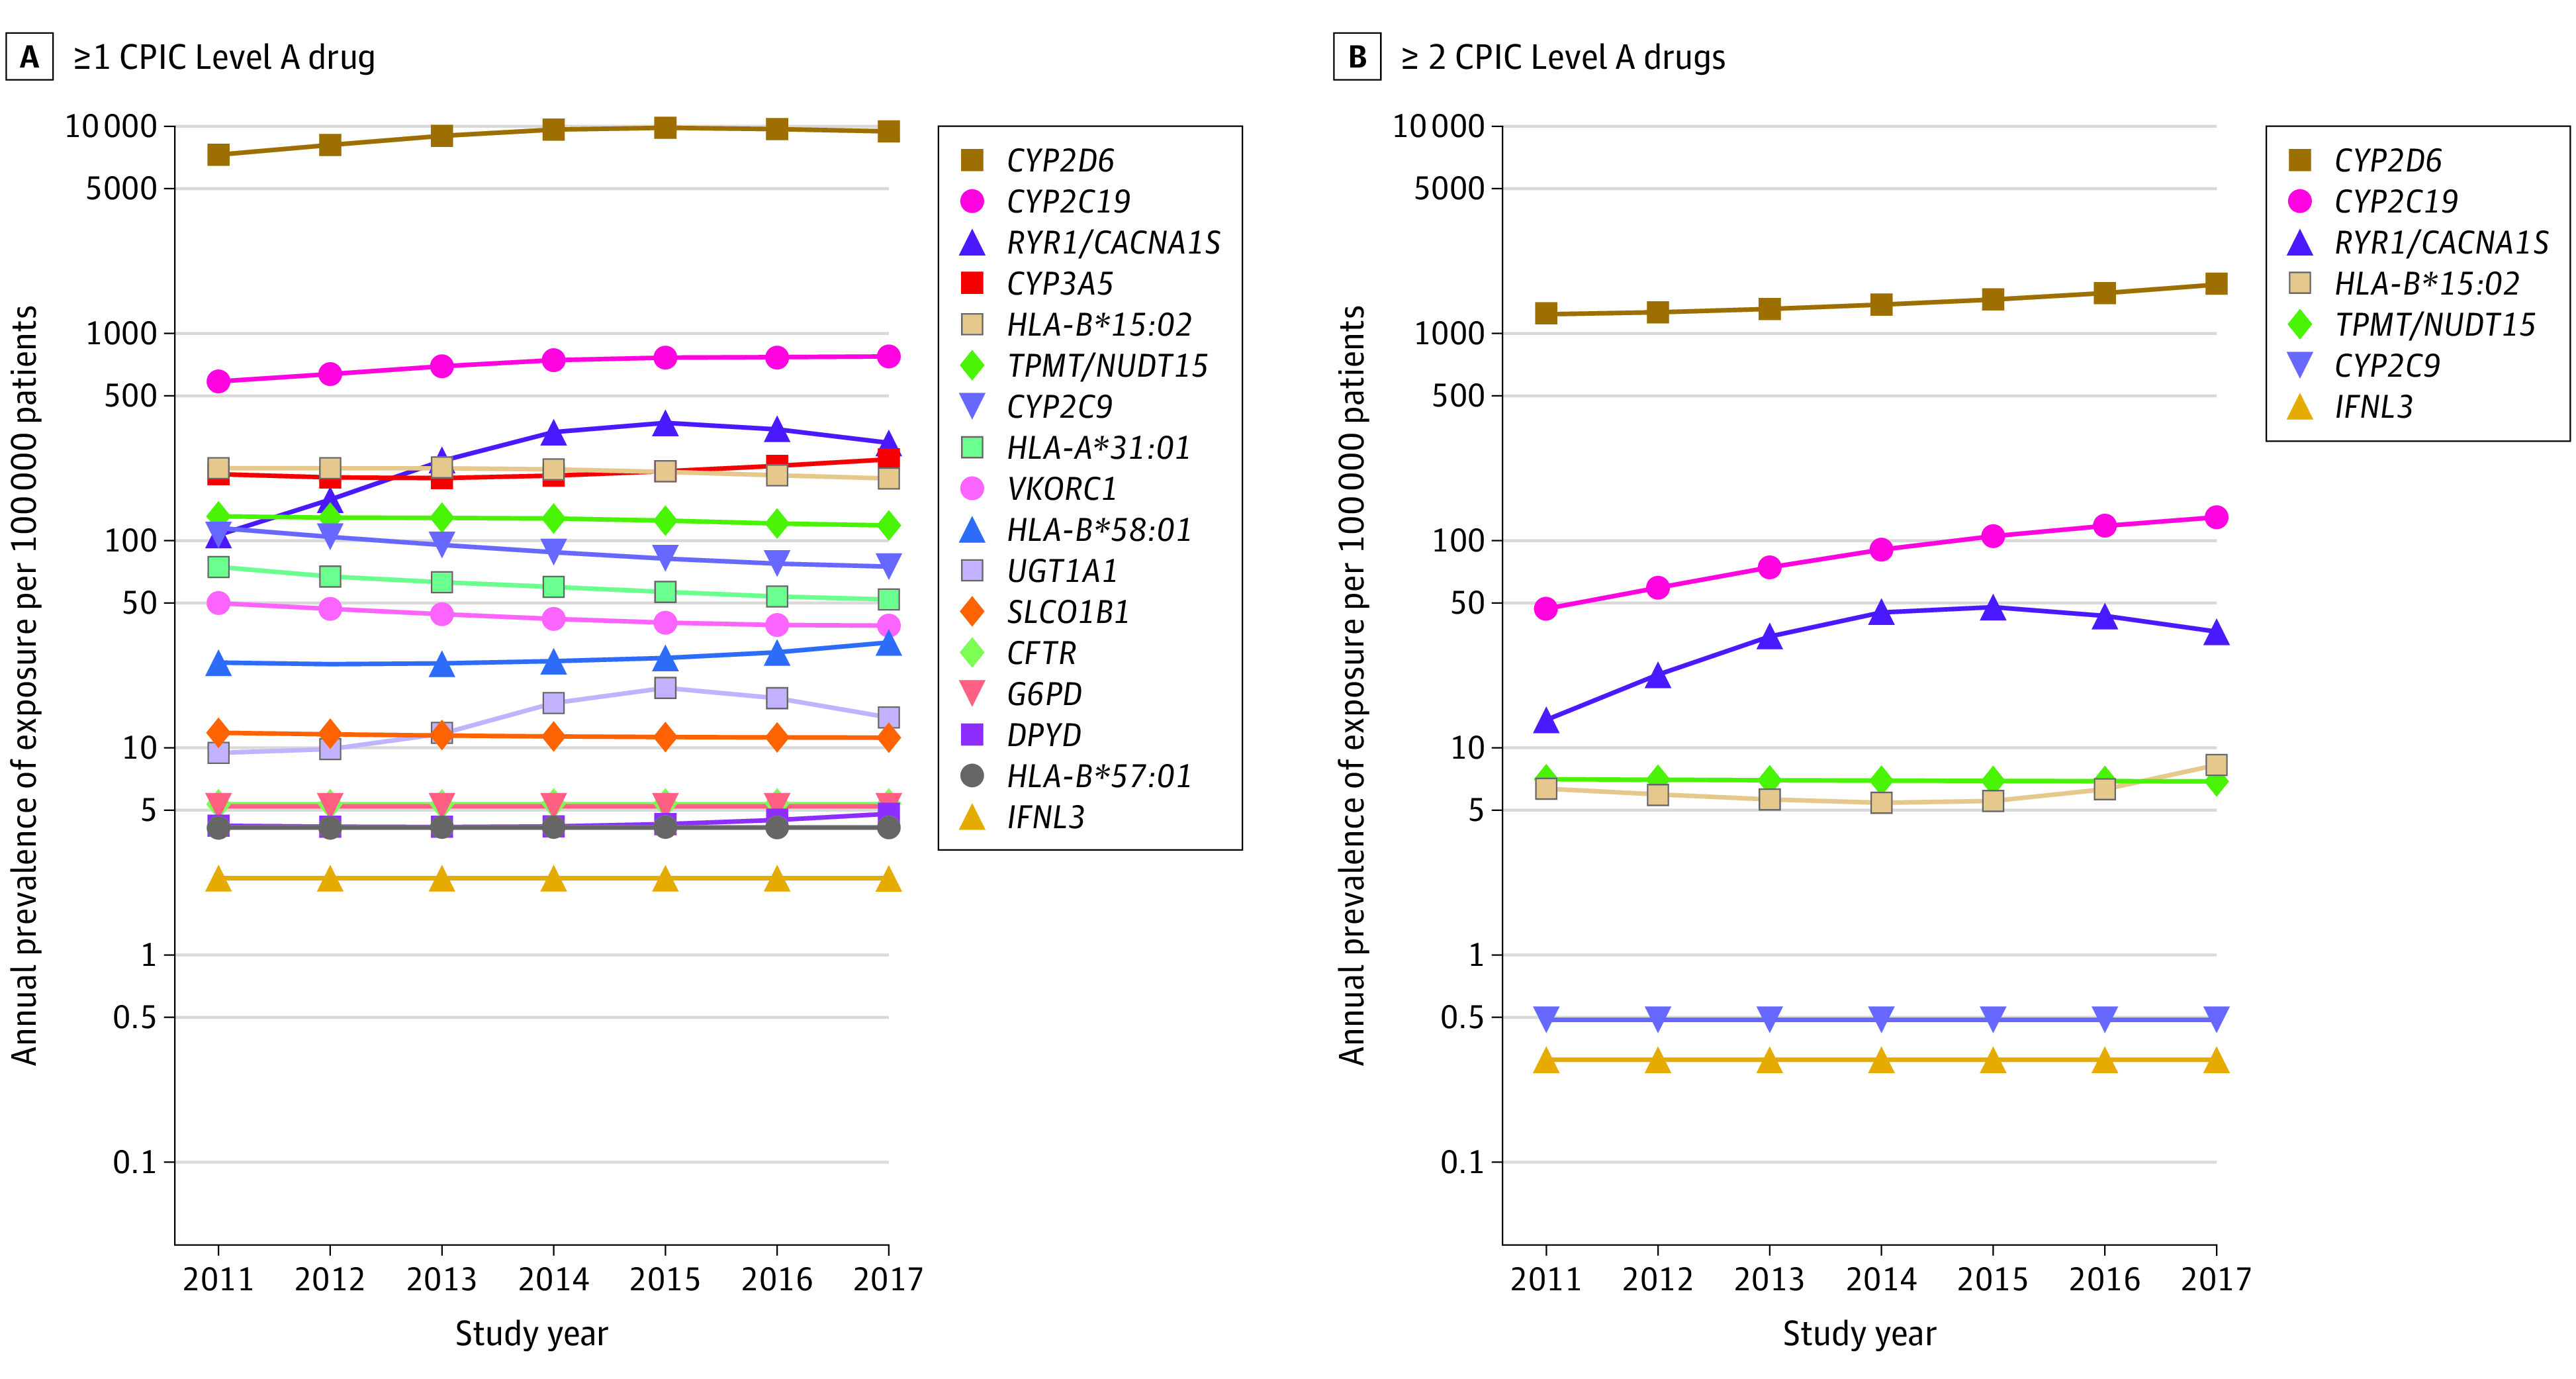
Annual Prevalence of Exposure to Clinical Pharmacogenetics Implementation Consortium (CPIC) Level A Medications Stratified by GeneA, Annual prevalence of exposure to at least 1 CPIC level A medication plotted on a log scale, stratified by the associated gene. B, Annual prevalence of exposure of at least 2 CPIC level A medications. The rate of exposure was estimated from the model and is displayed on a log scale.